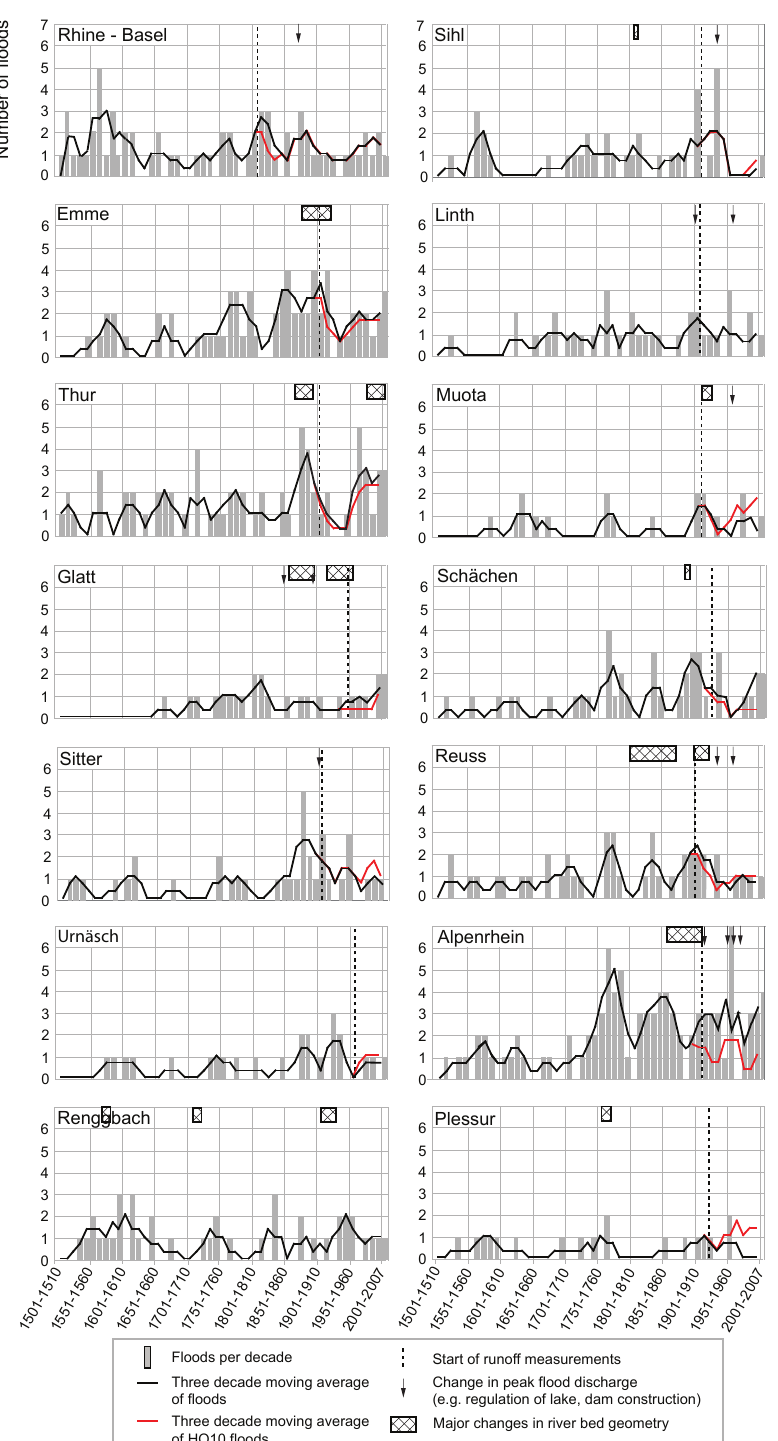
Fig. 3. Frequencies and three decadal mean running flood frequencies for 14 catchments in northern Switzerland. For the period with runoff measurements, different methods were used to define a flood (see Sect. 2.3). Also shown are changes in the river or catchments that influence flood damage and/or flood